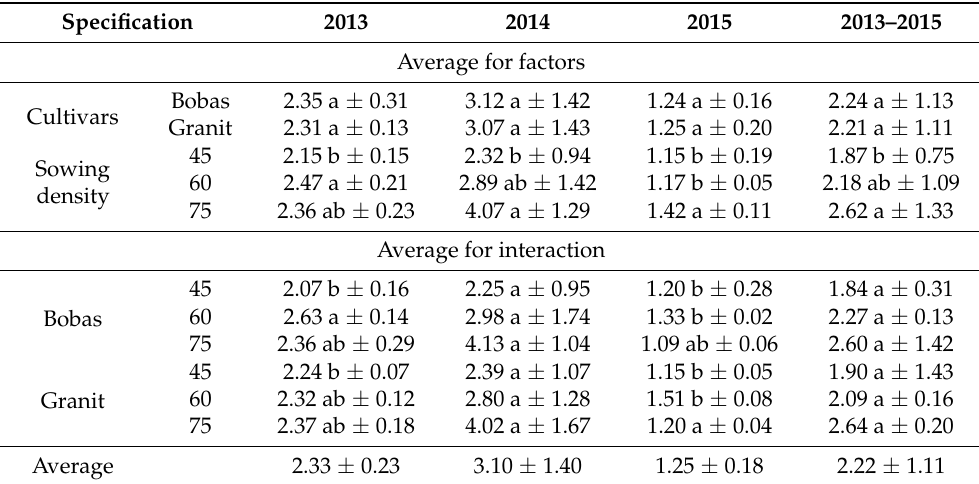
Table 7. Phosphorus accumulation in the faba bean straw (kg ha − 1 ) as influenced by the examined factors during the study years